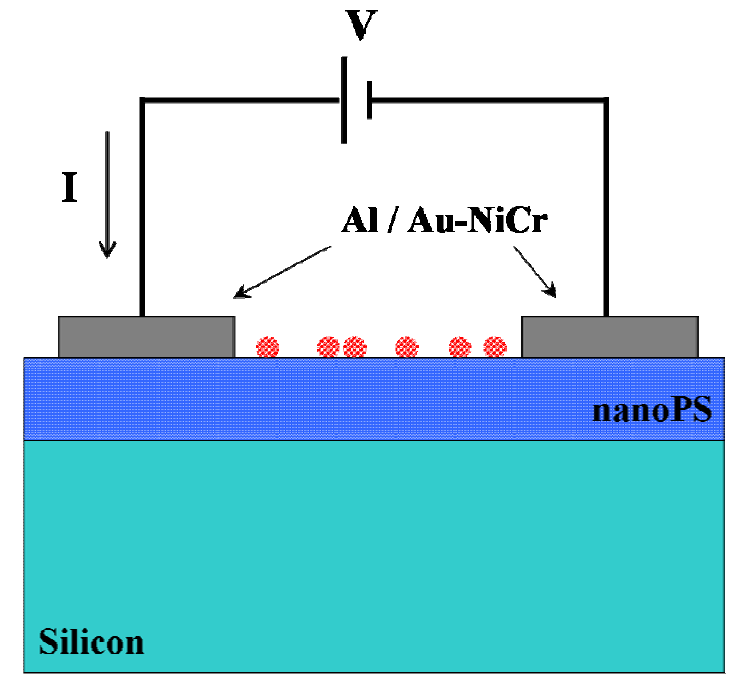
Figure 1. Cross-sectional view of a typical metal/nanoPS/metal biosensing device and configuration used for the electrical